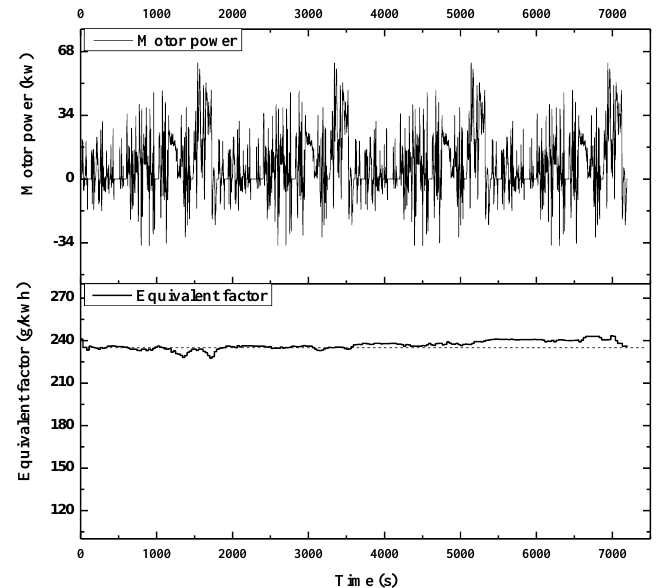
Figure 13. Calculated the equivalent factor and motor power in the A-ECMS strategy.